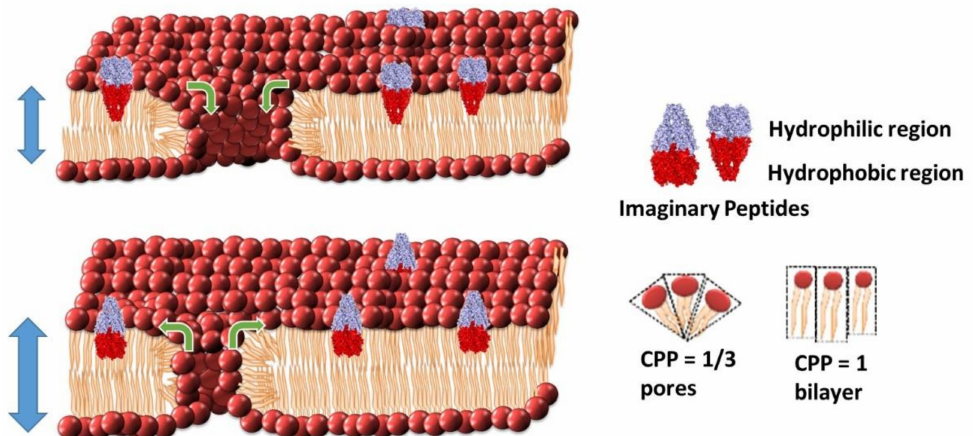
Figure 5. The Critical Packing Parameter (CPP) model of toroidal pore modulation by antimicrobial agents. This model predicts that the shape of peptides influences the lipid packing arrangement leading to either an increase in intrinsic membrane pore radius and an overall slight thinning of the membrane, as more lipids diffuse into pore regions, or a decrease in the intrinsic membrane pore radius with a thickening of the membrane as more lipids diffuse out of the pore